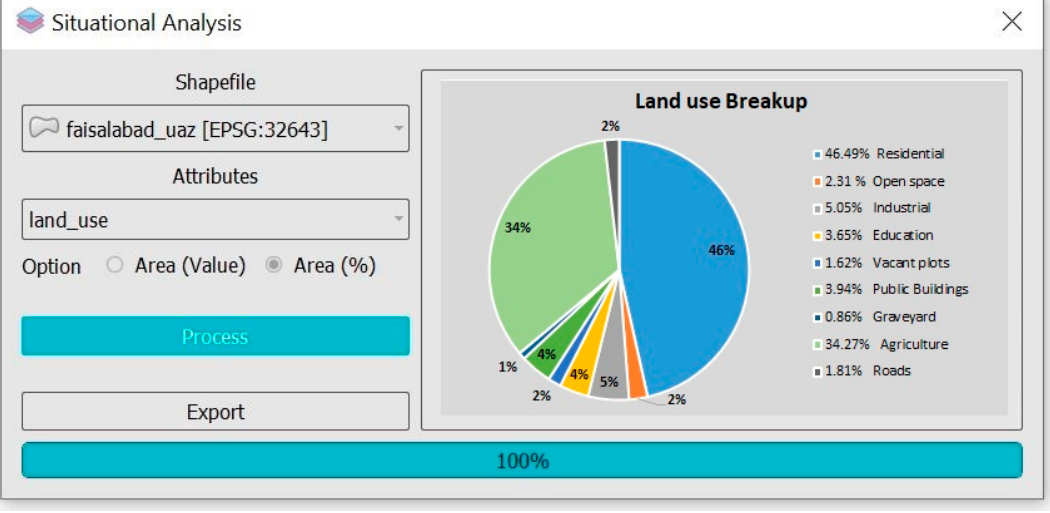
Figure 8. Descriptive statistical summary of layer